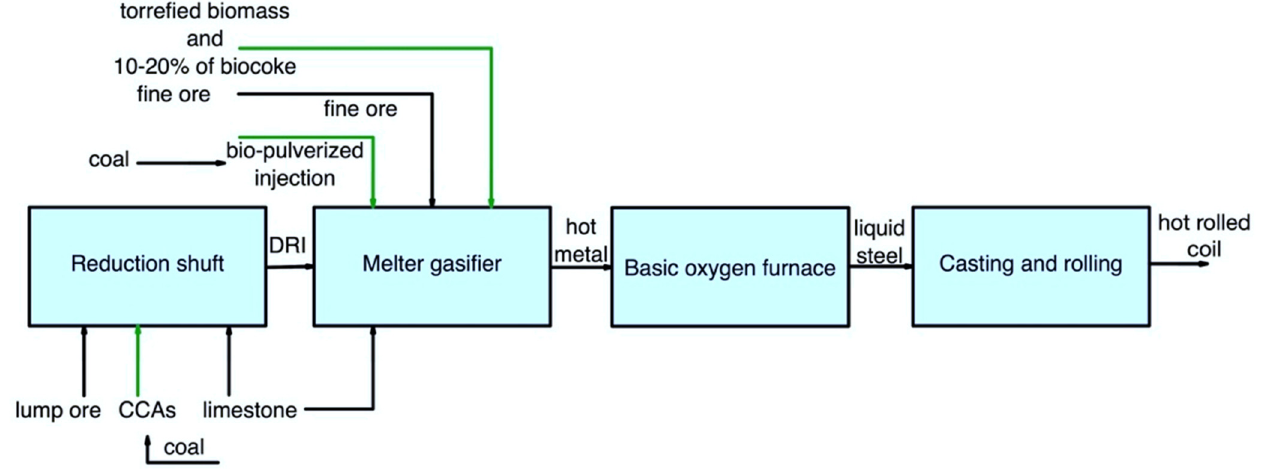
Figure 7. Main pathways for using secondary carbon bio-carriers in the COREX/BOF route.